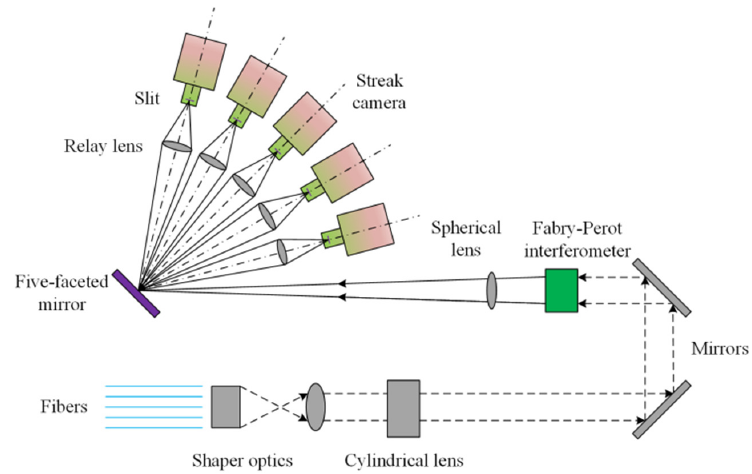
Figure 14. A schematic of five ‐ beam Fabry–Perot velocimeter.